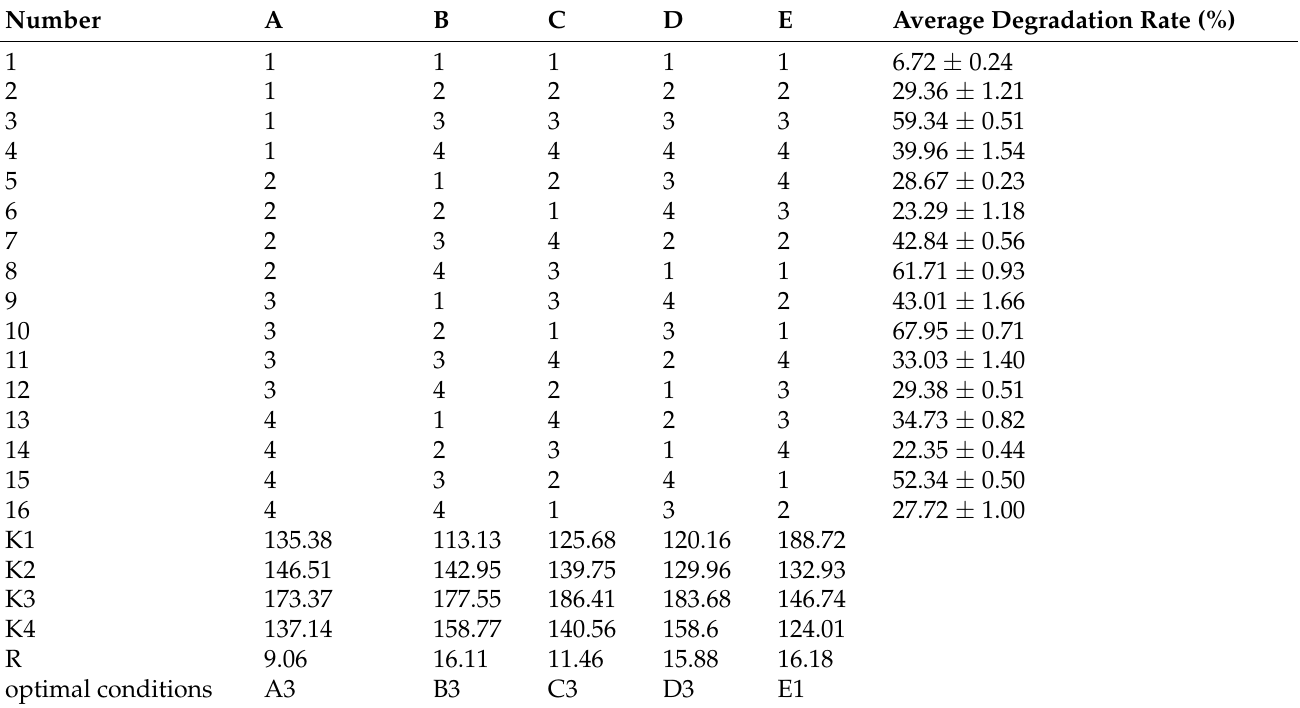
Table 6. Orthogonal test results for direct analysis. A is temperature, B is pH, C is salinity, D is the inoculation dose of strain, E is petroleum hydrocarbon concentration, Ki is the sum of the decreasing solution rates of all factors I, and R is